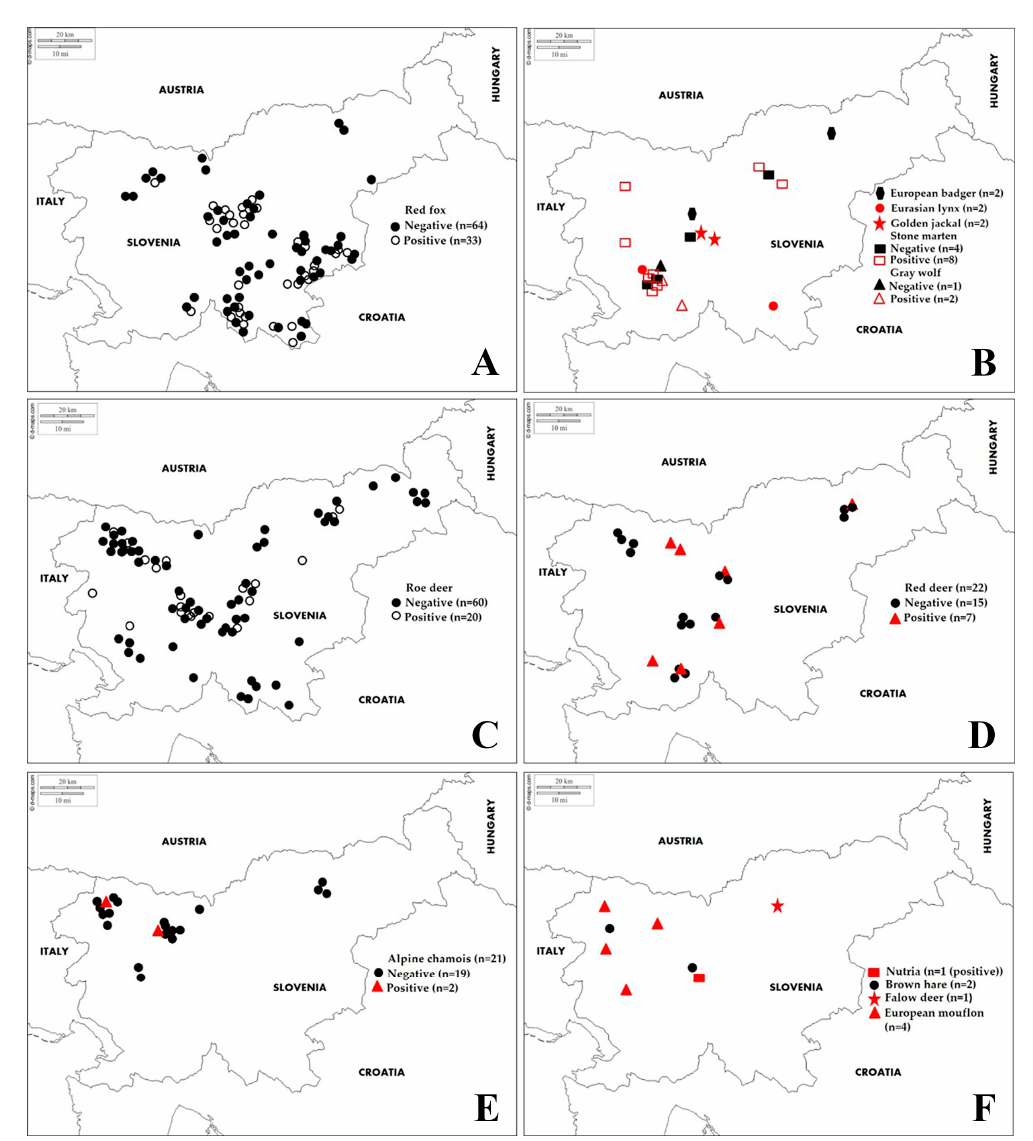
Figure 1. Geographical location of Leptospira interrogans antibody-negative and -positive samples of different wildlife species ( A )—red fox; ( B )—European badger, Eurasian lynx, golden jackal, stone marten, grey wolf; ( C )—roe deer; ( D )—red deer; ( E )—chamois; ( F )—nutria, brown hare, fallow deer, European mouflon) detected by MAT in Slovenia from 2019 to 2020.